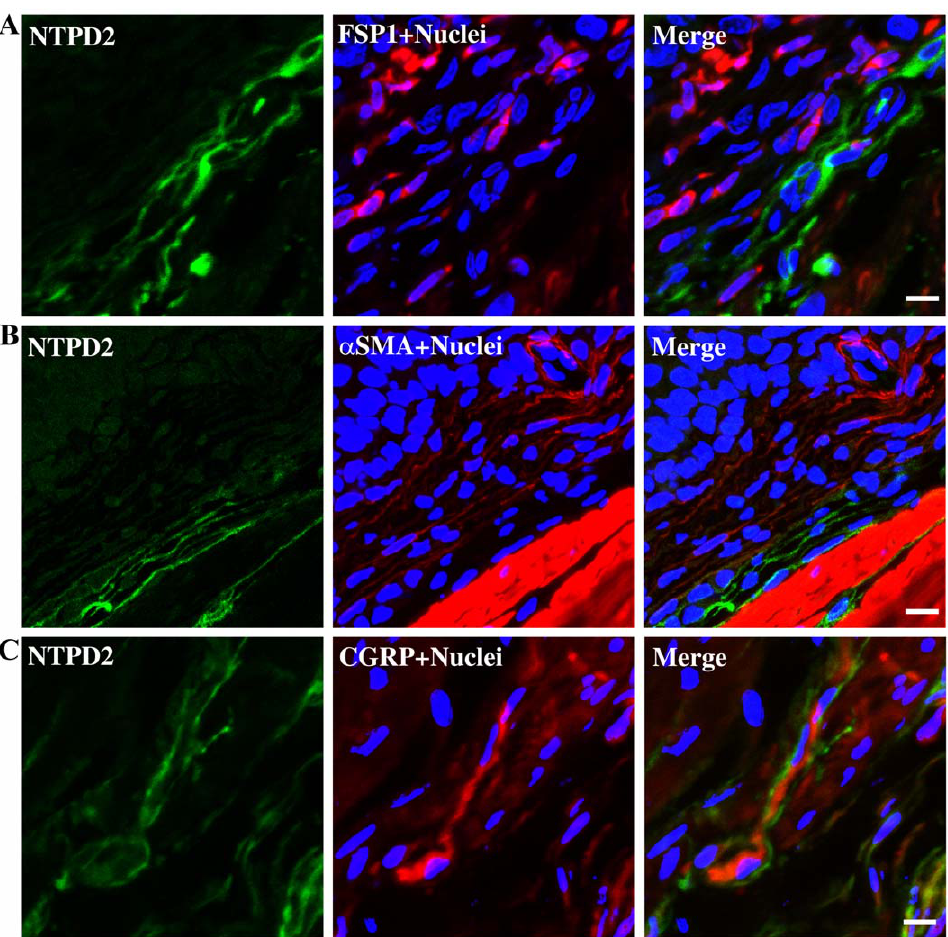
Figure 5. NTPD2 does not colocalize with fibroblasts, myofibroblasts or neurons. Cryosections of mouse bladders were coimmunostained with NTPD2 (green) and antibodies to marker proteins for A) fibroblasts – FSP1 (red), B) myofibroblasts – a SMA (red) and C) afferent nerves – CGRP (red). Nuclei are blue and color merged panels are shown on the right. Scale bars =10 m m.